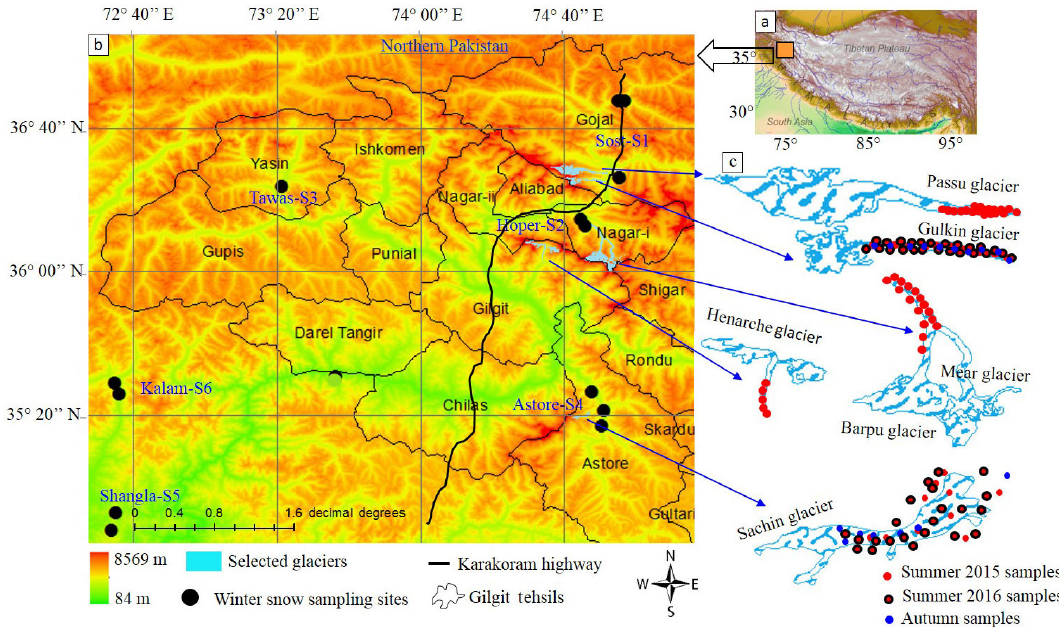
Figure 1. The study area and sampling sites: (a) Himalayan mountain range and Tibetan Plateau, (b) winter sampling sites (solid black circles), (c) glaciers selected for summer and autumn